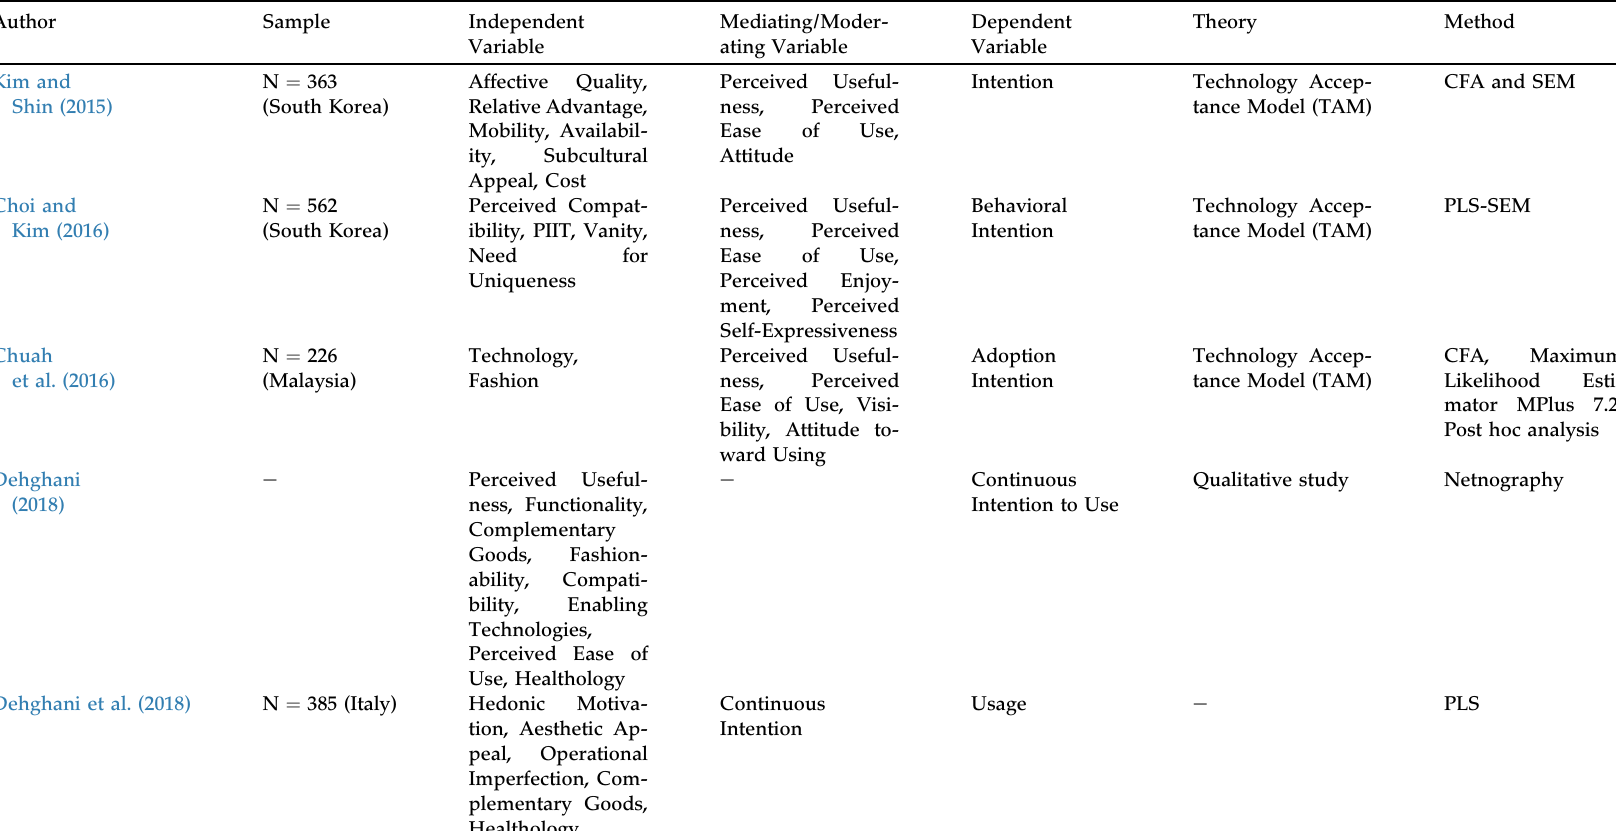
Table 1. Past studies on smartwatch adoption and usage